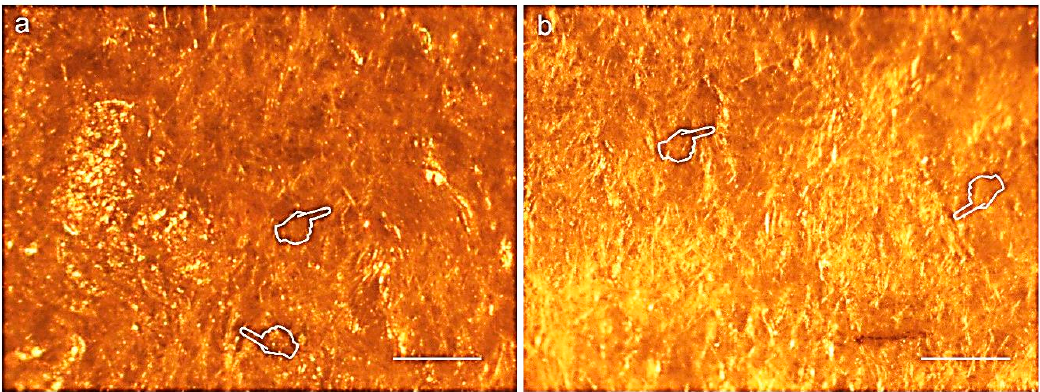
Figure 5. Representative light micrographs of surfaces of Duo-Teck membrane at the outer ( a ) and inner ( b ) surfaces before immersion. The membrane has a surface formed by numerous frames arranged in a disordered manner, with large gaps intermingling the entire structure (pointers). Scale bar is 1000 µm in a, and 2000 µm in b.